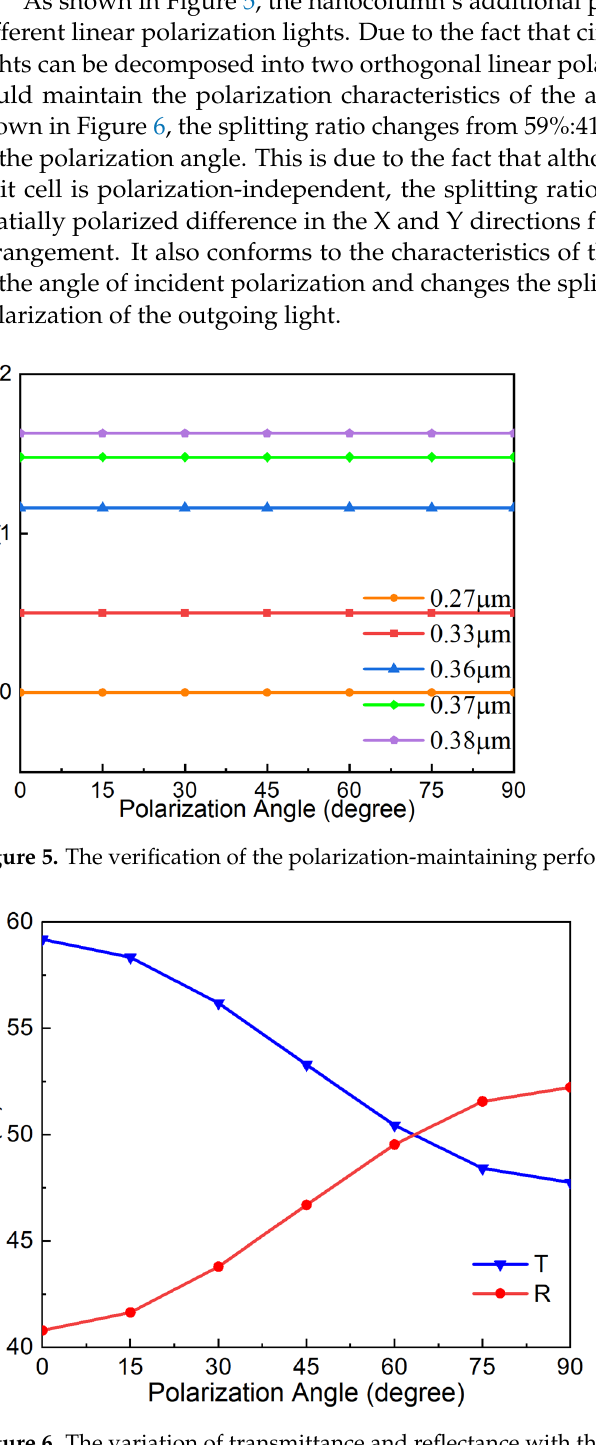
( b ) The intensity of the Y − Z plane at the transmissive end of the metasurface beam splitter under the incoming x-polarized light of 1.55 µ m wavelength. ( c ) The intensity of the Y − Z plane at the reflective end of the metasurface beam splitter under the incoming y-polarized light of 1.55 µ m wavelength. ( d ) The intensity of the Y − Z plane at the transmissive end of the metasurface beam splitter under the